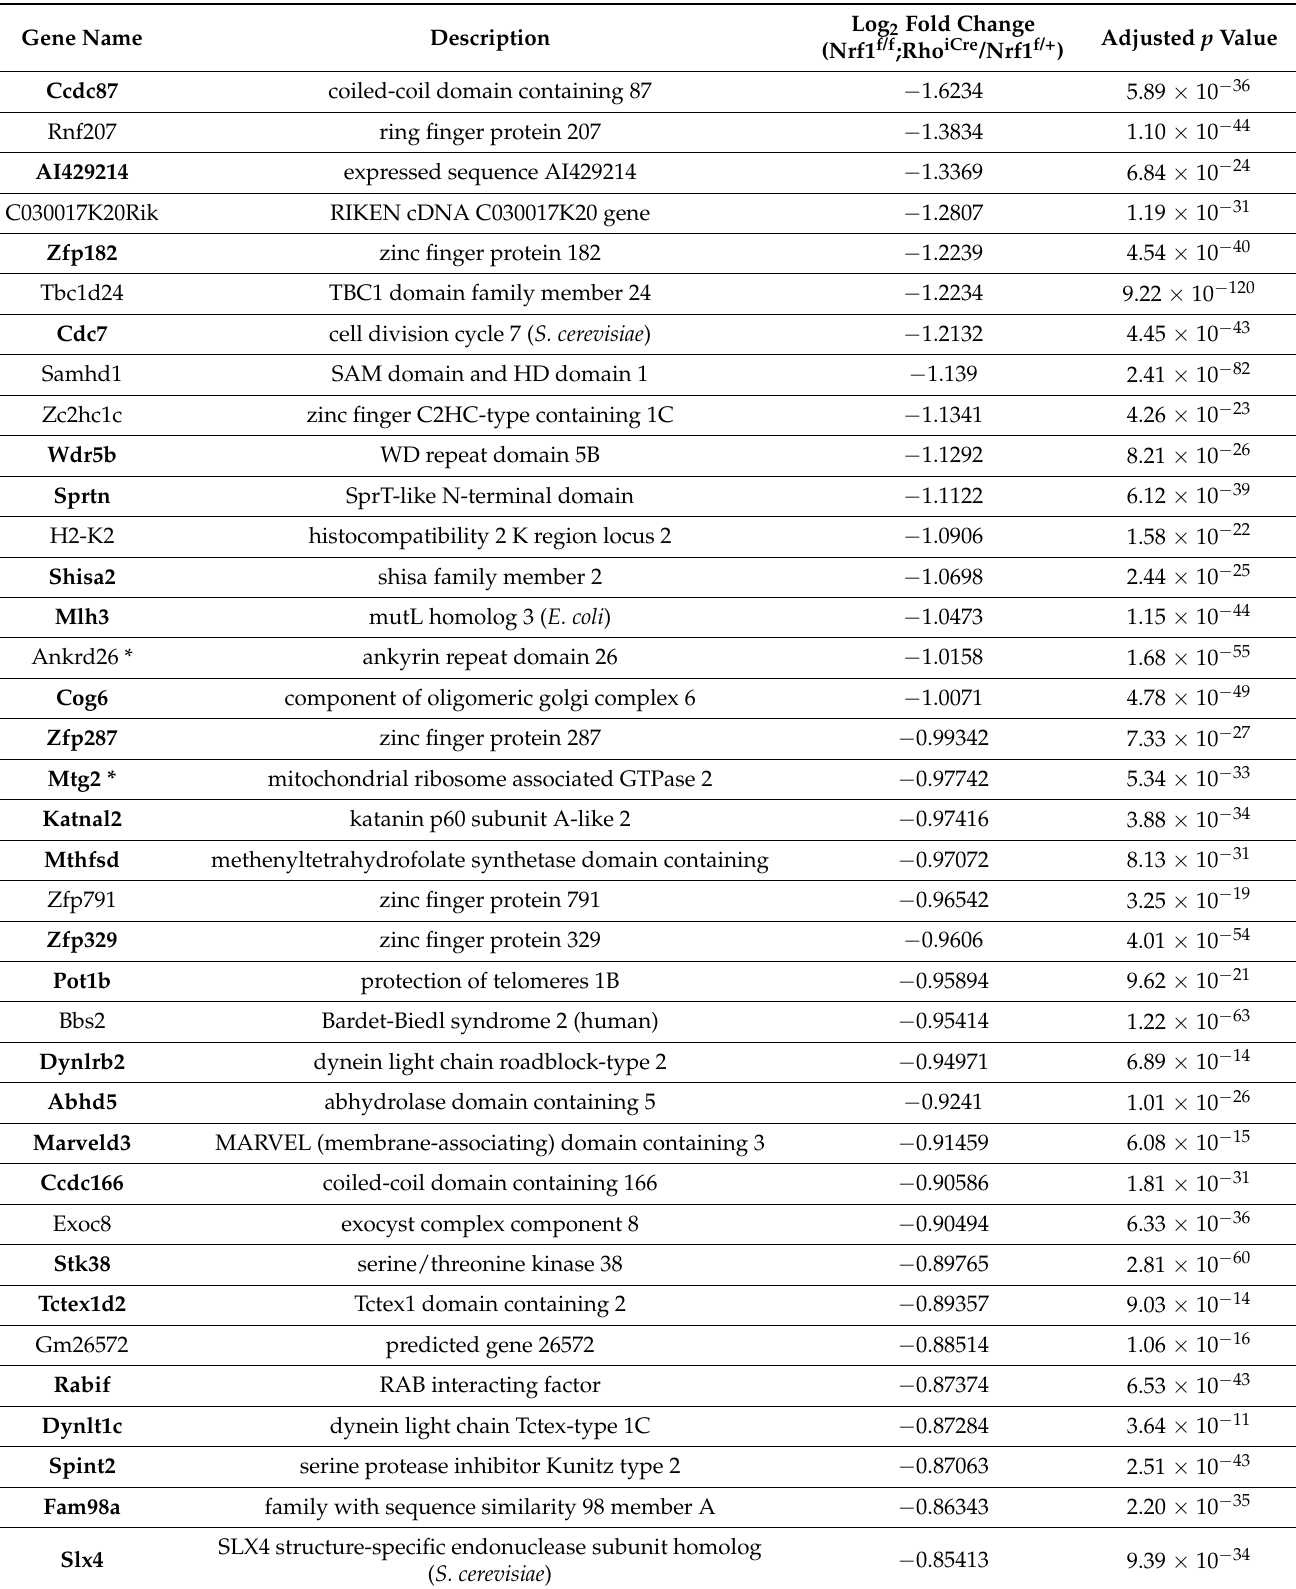
Table 1. The most sensitive genes in Nrf1 f/f ; Rho iCre retina. Gene names in bold font are direct targets of Nrf1 found in P0 brain (GEO dataset: GSE161808). Genes marked with an asterisk encode proteins found in